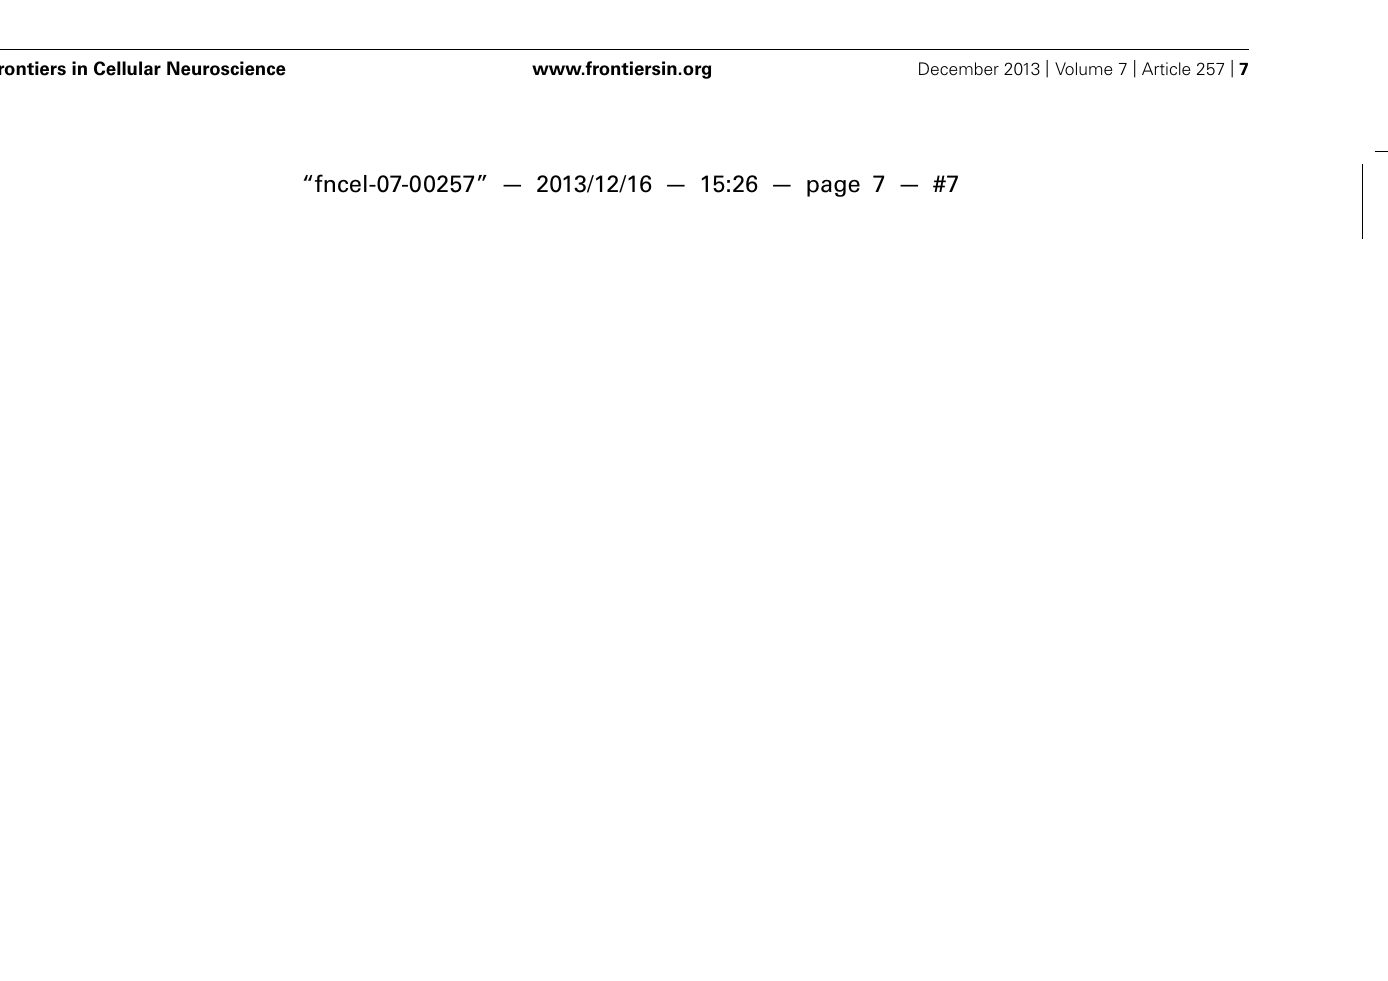
FIGURE 5 |Astrocytes are a source ofTNF α following entorhinal denervation in vitro . (A) Immunostainings for TNF α (red) and GFAP (green) reveal that both markers are upregulated post lesion compared to control. Arrows are pointing at examples of TNF α and GFAP-positive cells. The regions of interest (ROIs) used for analysis of changes in the outer molecular layer (OML), inner molecular layer (IML), and granule cell layer (GCL) are indicated (ToPRO nuclear staining, blue). Scale bars: 40 μ m. (B–D) Quantification of immunofluorescence for GFAP, TNF α colocalized with GFAP and TNF α without GFAP in the GCL, IML, and OML. GFAP is upregulated predominantly in the OML following denervation (B) . Only the